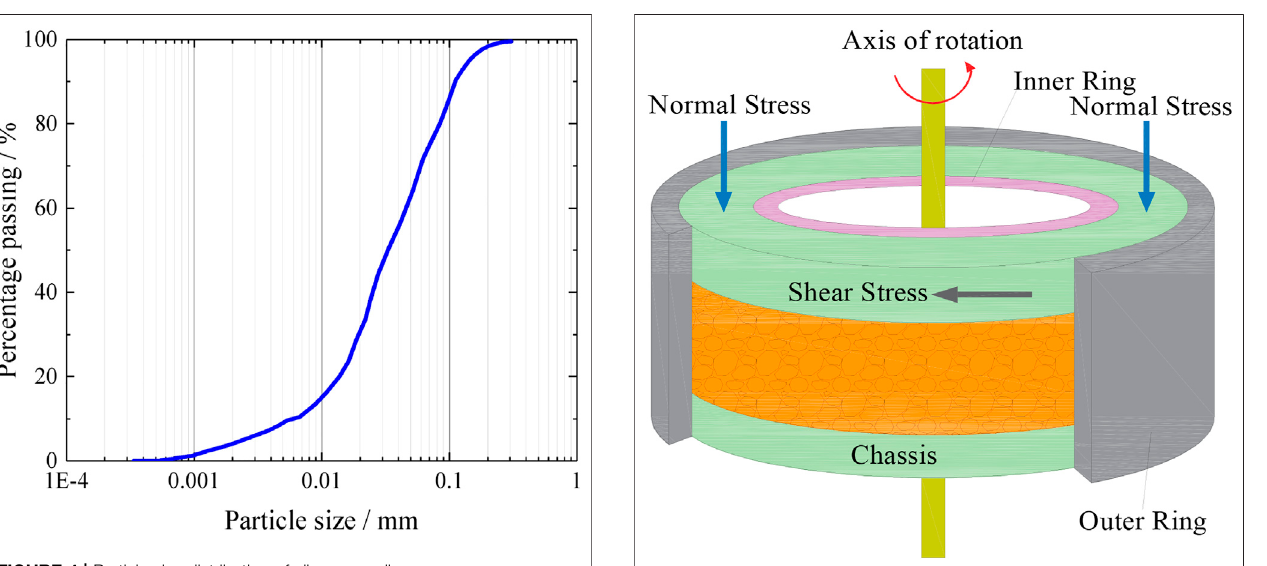
FIGURE 6 | Schematic diagram of ring shear test.